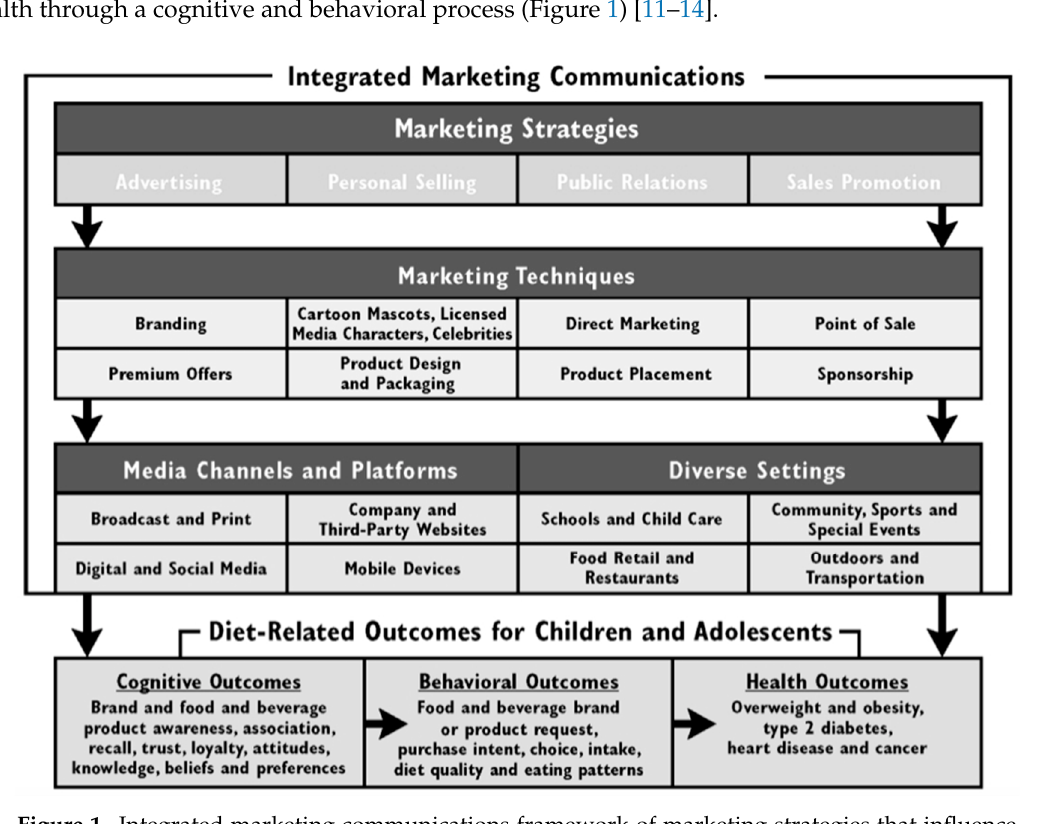
Figure 1. Integrated marketing communications framework of marketing strategies that influence the diet-related outcomes for children and adolescents. Source: Kraak, V; Rincon Gallardo, S; Sacks, G. An accountability evaluation for the International Food & Beverage Alliance’s Global Policy on Marketing Communications to Children to reduce obesity: a narrative review to inform policy. Obes. Rev. 2019 ; 20 , 90–106 [13]. Reprinted with permission.